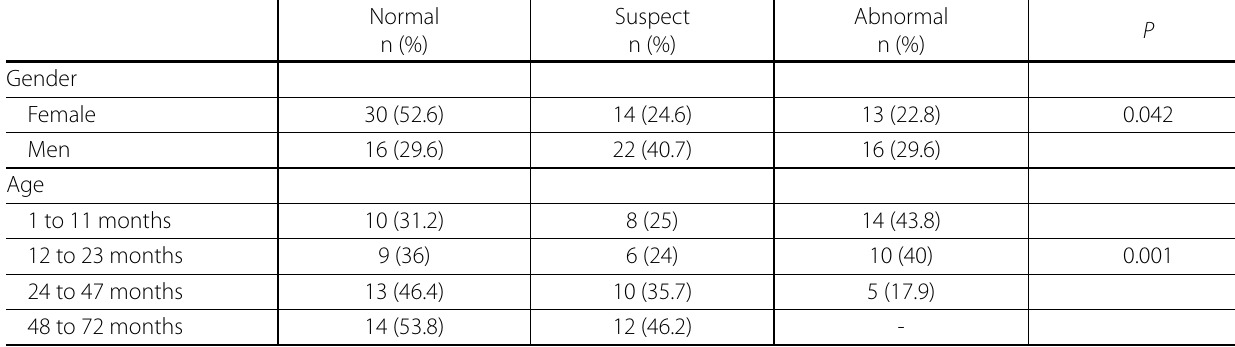
Table 4. Gender and age related to Denver II (n =